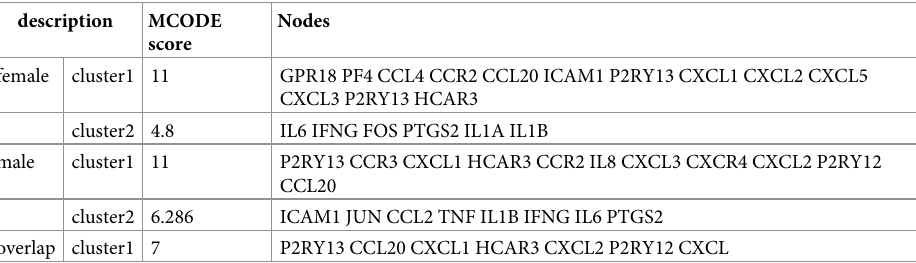
Table 2. MCODE modules from PPI